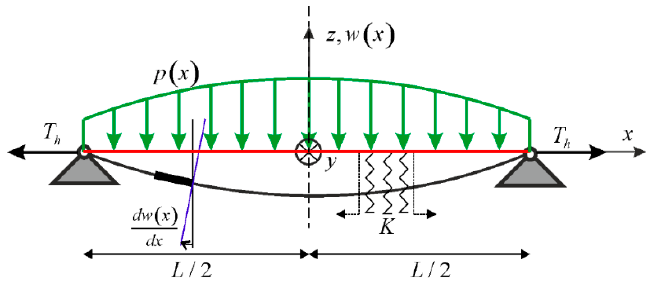
Figure 2. A membrane modelling the reinforcement of the LTP, boundary conditions and coordinate system.